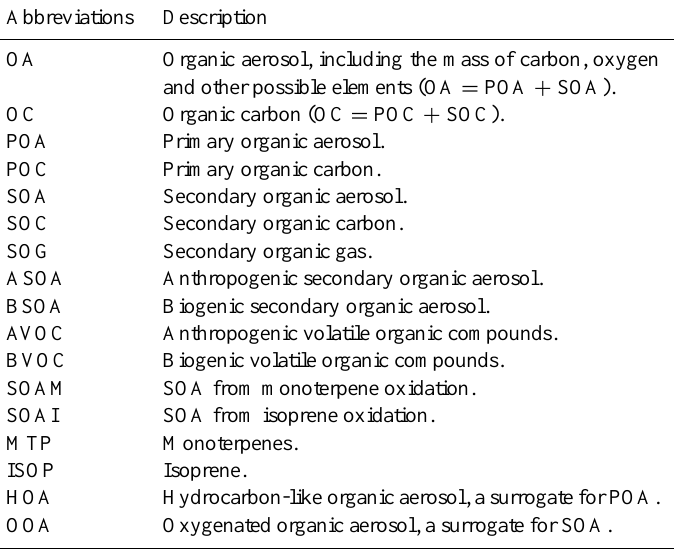
Table 1. Abbreviations used in this